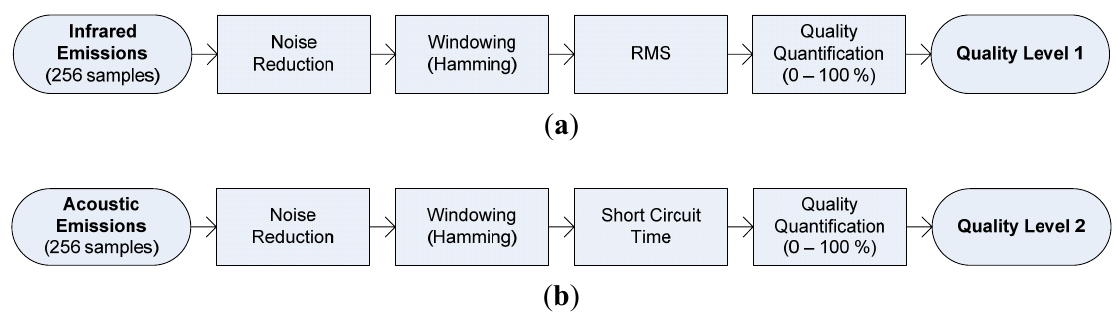
Figure 6. Pre-processing data signal stages, ( a ) infrared signal, ( b ) acoustical signal.